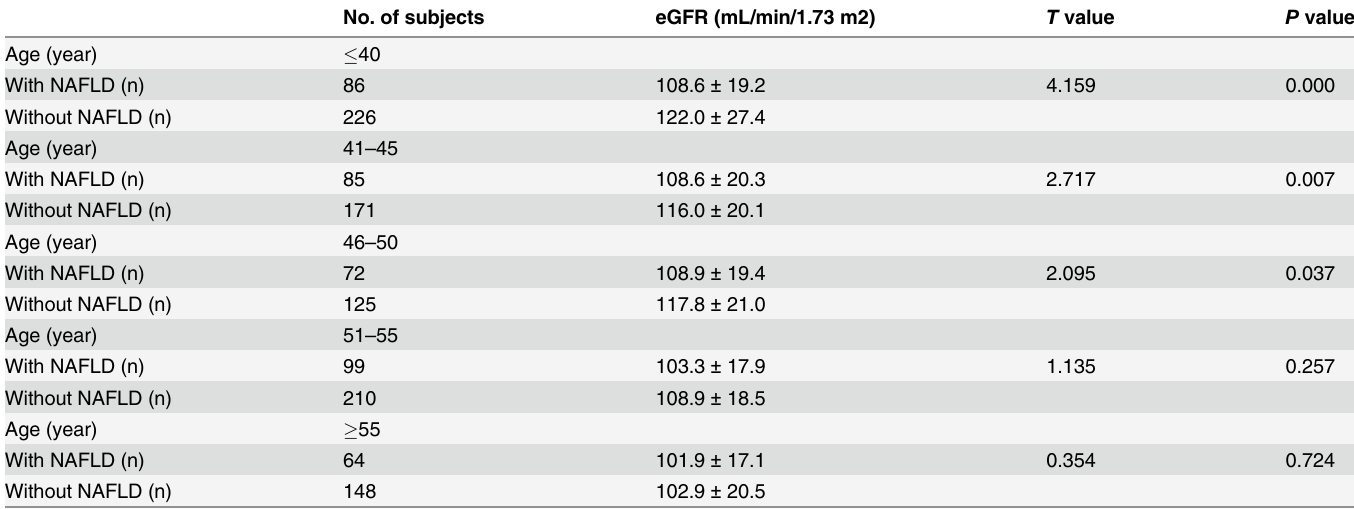
Table 3. Relationships between eGFR and NAFLD in different ages.